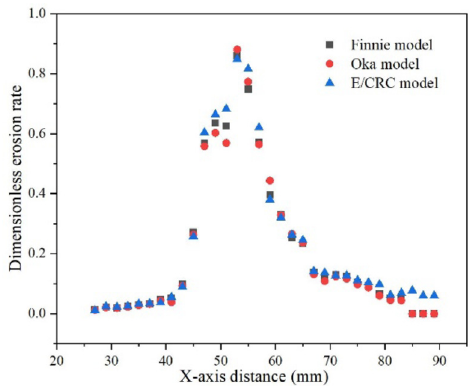
Fig. 4. Comparison of dimensionless erosion rates of three erosion models.